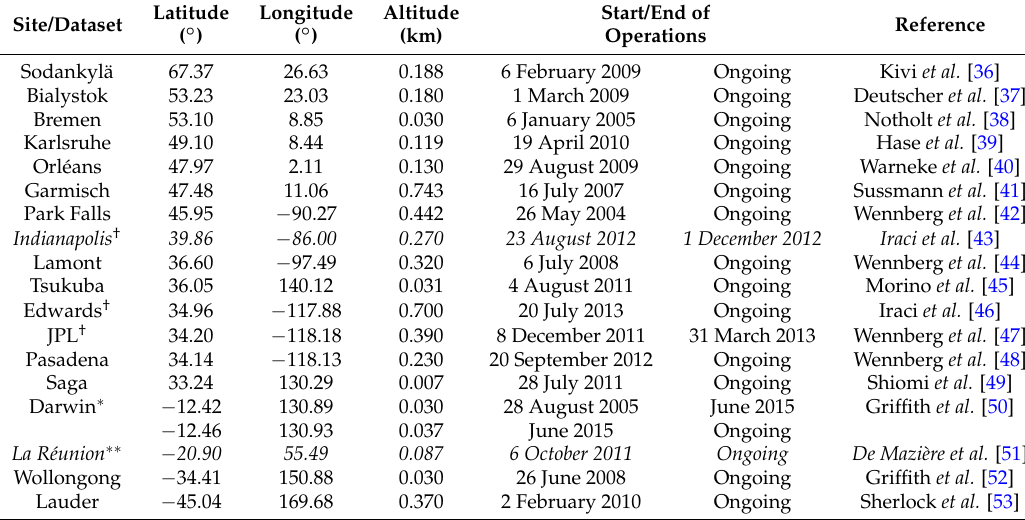
† The Indianapolis ( cf. the Supplementary Material), Edwards and JPL datasets were acquired with the same instrument; for the explanation, please see the site-specific notes [54]; ∗ the instrument in Darwin was recently relocated; ∗∗ for La Réunion, coincidences with TANSO-FTS ocean scans only and for relaxed geographic criteria of ± 2 ◦ in latitude and longitude ( cf. the Supplementary